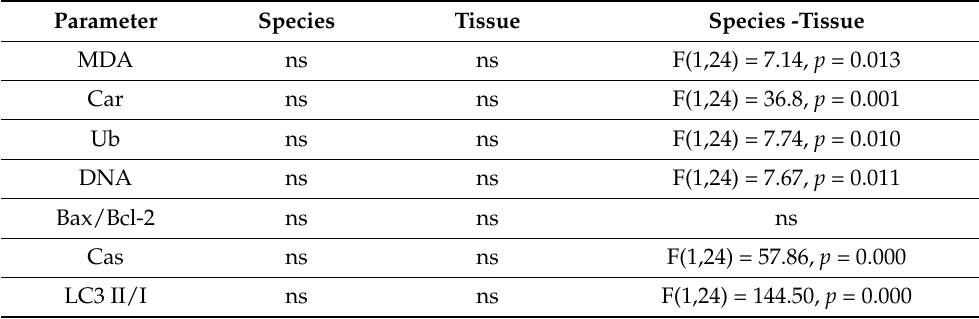
Figure 9. Graphical representation of molecular and biochemical biomarkers measured in the gills (g) and liver (l) of Danio rerio (zebrafish) and Perca fluviatilis (perch) (for graphical purposes caspases and ubiquitin values were divided by 10). Table 1. Nested Anova of the effects of species, tissue and species-tissue combination on the molecular and biochemical indicators studied.